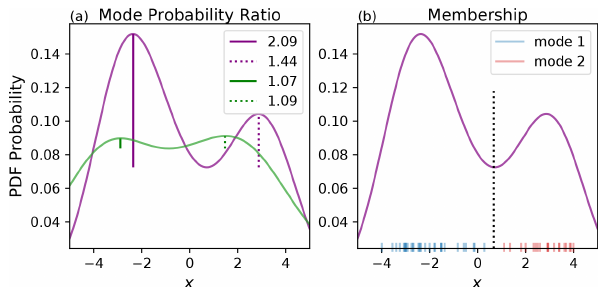
Figure 2. (a) Synthetic data representing how the magnitude of the mode probability ratio has been quantified for two distributions. The mode probability ratio will vary depending on which mode you are measuring against. (b) How ensemble members have been assigned to a mode based on if they are less than the local minimum value in the PDF of the distribution (blue) or greater than the local minimum